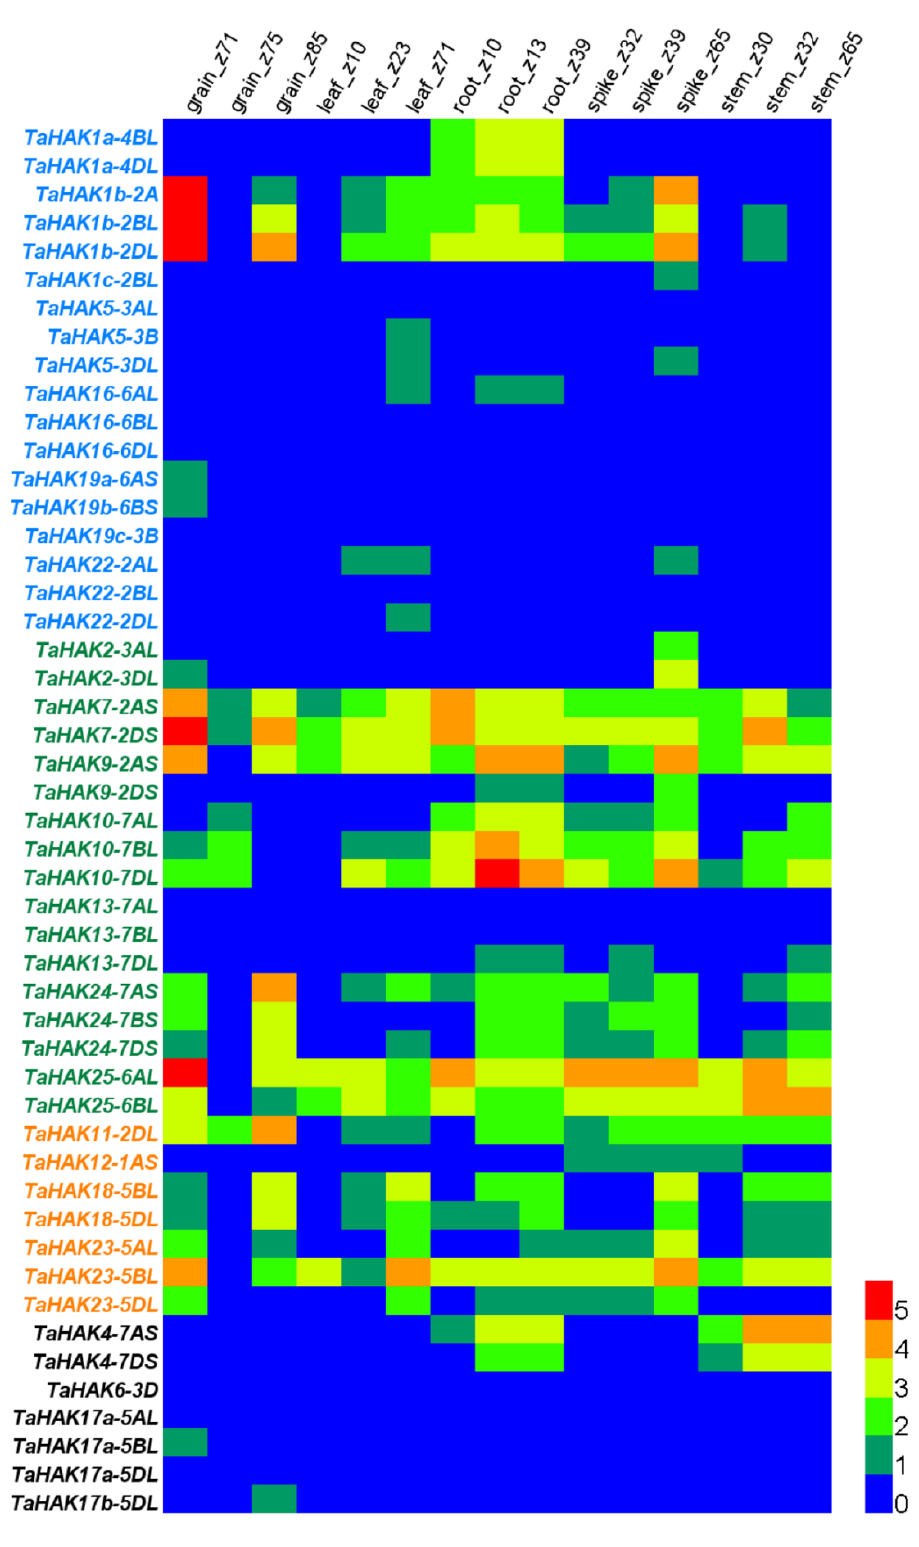
Figure 4. Heat map showing the expression of wheat TaHAK genes in various wheat tissues at different developmental stages. RNA-seq data for bread wheat cultivar Chinese spring were obtained from dataset “developmental timecourse in five tissues” presented in WheatExp database [31] Number 0 to 5 represent the range of expression levels (from the lowest to the highest) of the examined genes.